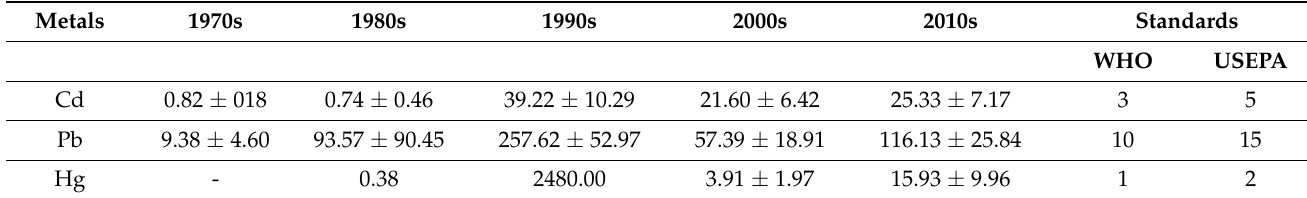
Table 1. Total heavy metal concentrations (mg L − 1 ) of the global river and lake water bodies from the 1970s to the 2010s, and concentrations of heavy metals in water as per World Health Organization (WHO) and United States Environmental Protection Agency (USEPA) standards